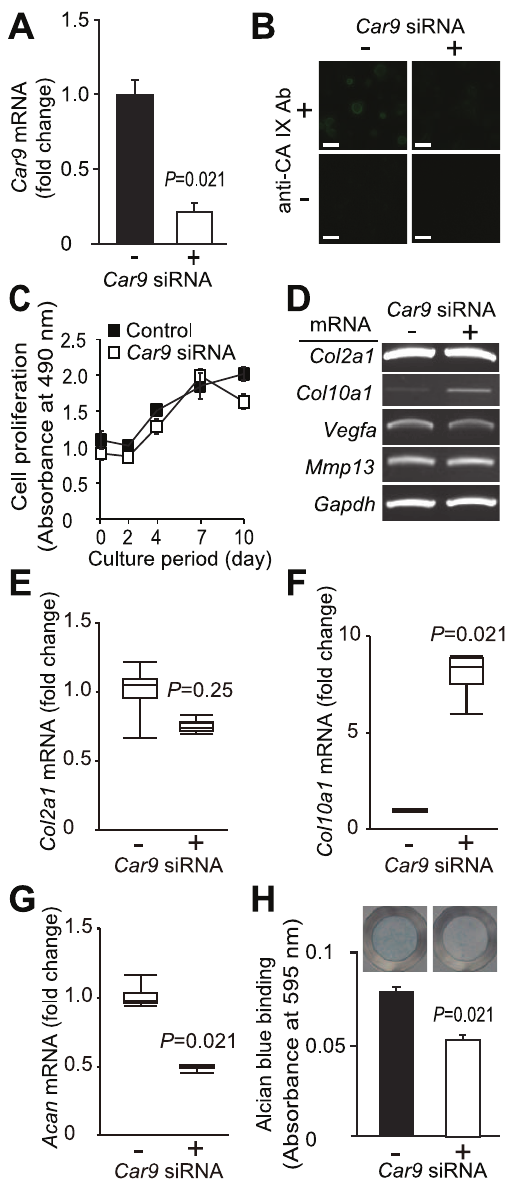
Figure 3. Effects of Car9 siRNA on chondrocyte proliferation and expressions of marker genes of chondrocyte differentia- tion. Car9 siRNA or control siRNA was introduced into primary chondrocytes isolated from the rib cages of 1-day-old postnatal ddY mice. A. The expression of Car9 mRNA was analyzed by real-time RT- PCR at 48 hours after introduction of Car9 siRNA or control siRNA, with the level normalized to that of Gapdh . Data are expressed as the mean 6 SD (n=4) for fold changes caused by introduction of Car9 siRNA. P - value obtained by two-tailed Mann-Whitney U -test (n=4) indicated that the Car9 siRNA used in this study significantly lowered the expression level of Car9 mRNA ( a =0.05). B. Expression of CA IX protein in chondrocytes was detected by immunocytochemical staining at 48 hours after introduction of control siRNA (left 2 panels) or Car9 siRNA (right 2 panels). Lower 2 panels show the results obtained without primary antibody against CA IX. Bar, 50 m m. C. Car9 siRNA (unfilled square) or control siRNA (filled square) was introduced to chondrocytes on day 0. Proliferation of chondrocytes was assessed spectrophotometrically using CellTiter 96 H Aqueous One Solution. Data are expressed as the mean 6 SD (n=4). At each time point, Mann- Whitney U -test with Bonferroni correction was performed to evaluate the difference between control siRNA- and Car9 siRNA-introduced